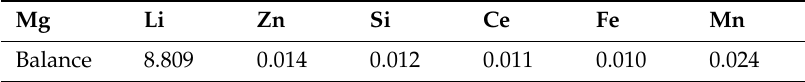
Table 1. Chemical composition of Mg-9Li alloy (mass fraction